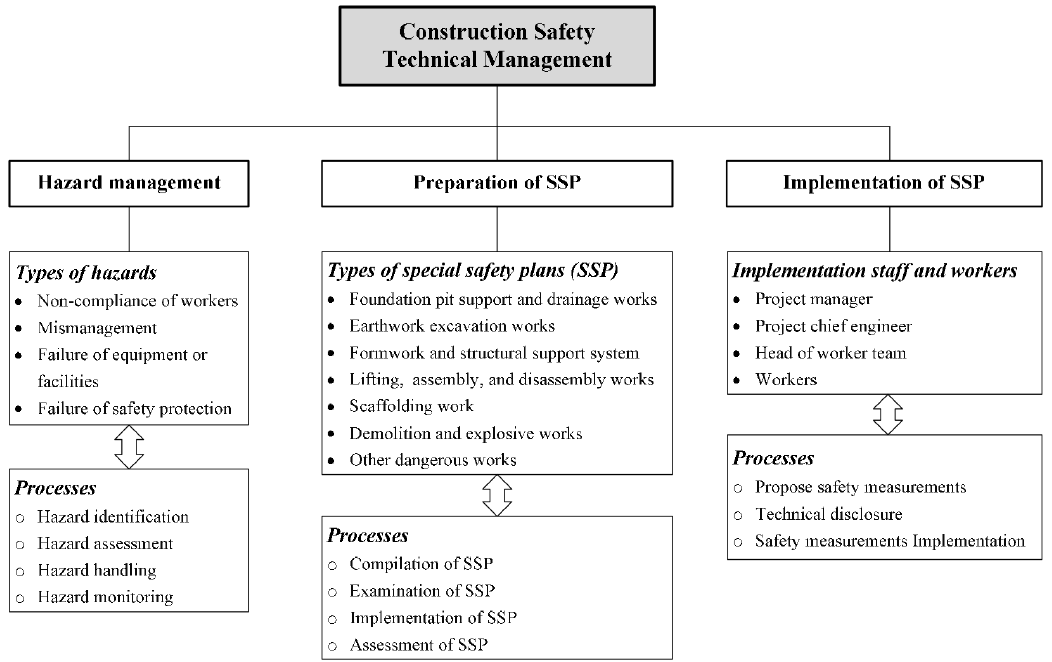
Figure 3. Structure of the safety technical management